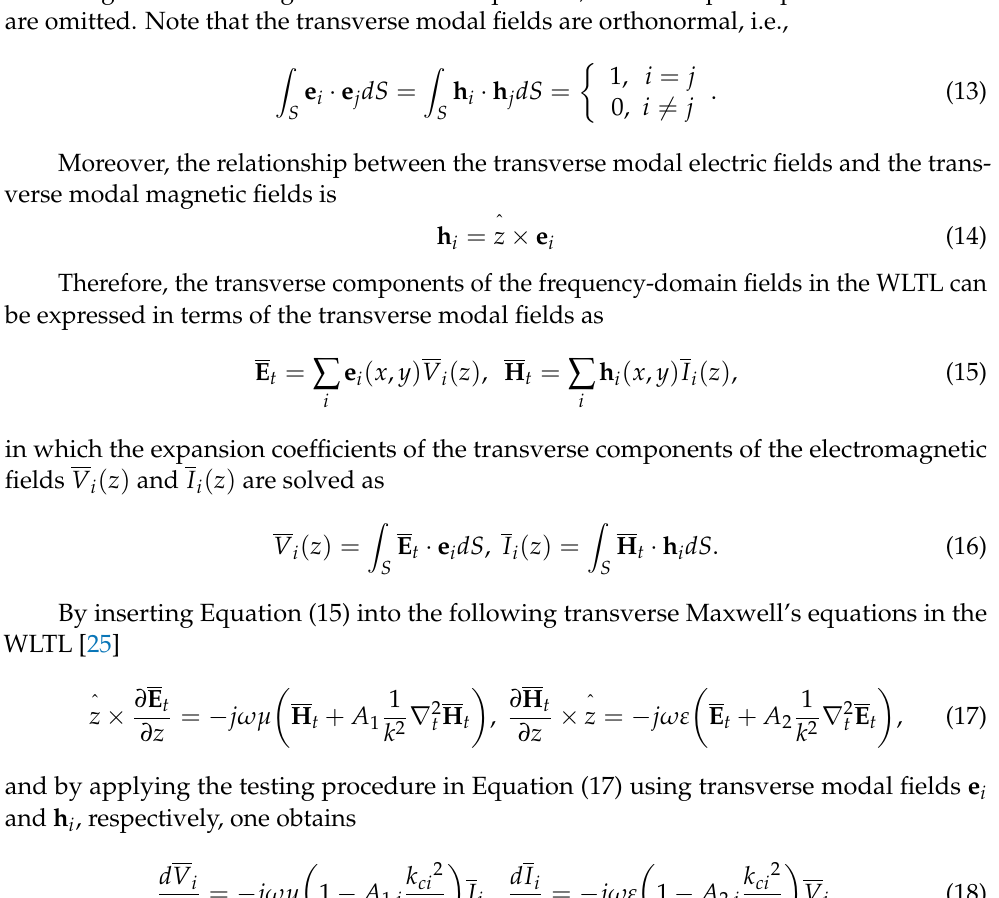
( h TE ) and e TM ( h TM ) are sorted in m m m m